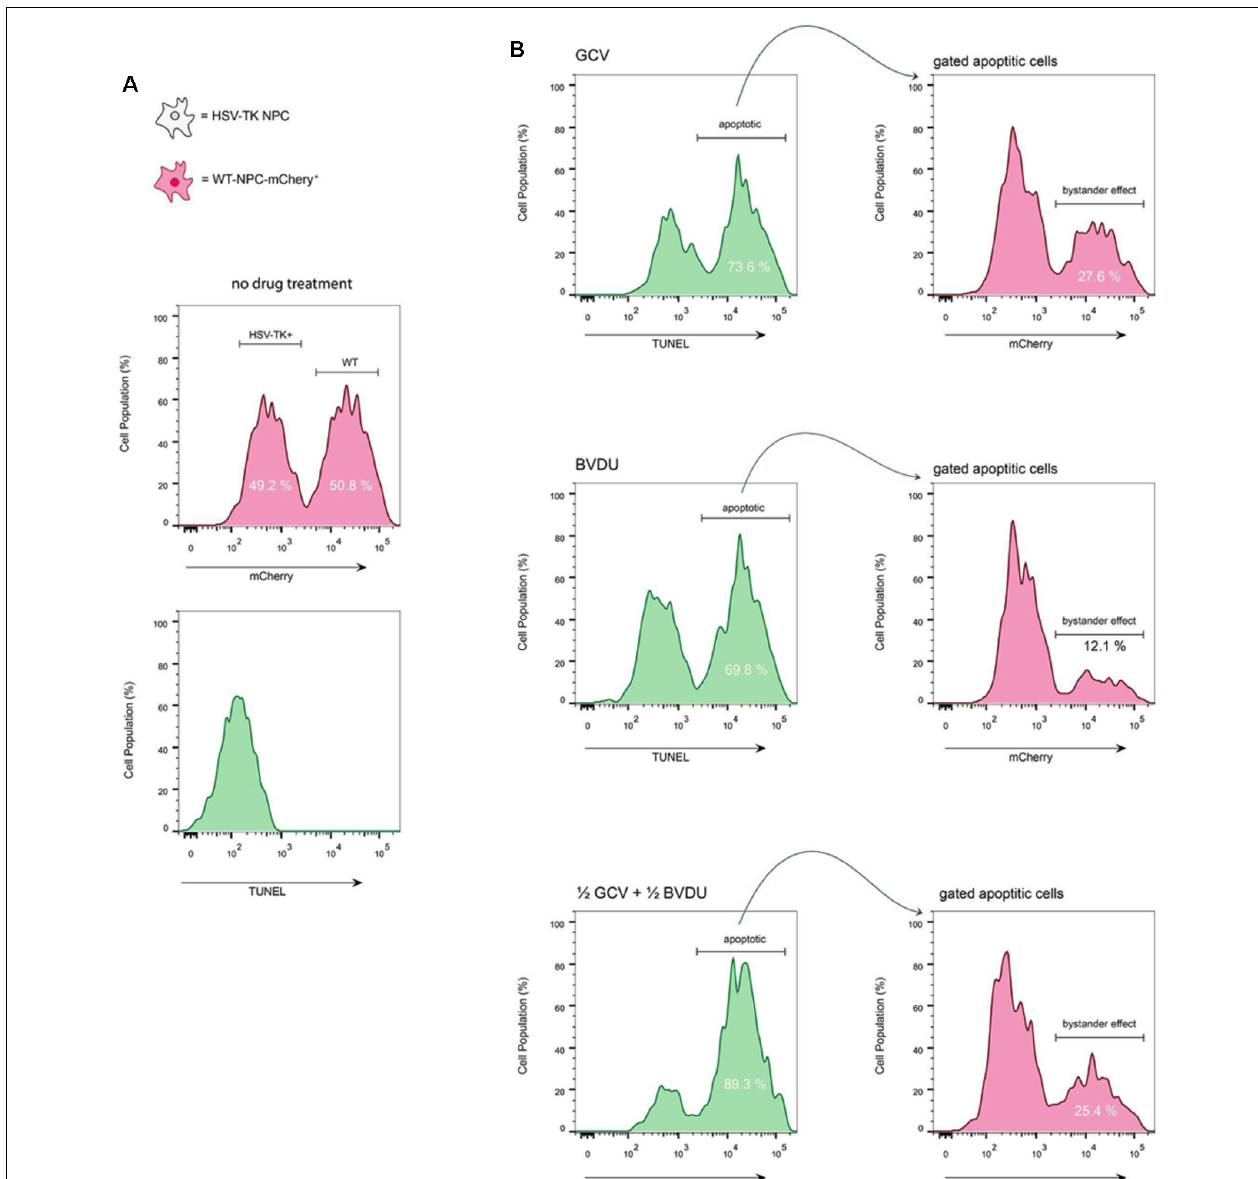
FIGURE 4 | TUNEL assay of co-cultured HSV-TK + NPCs and WT-mCherry + NPCs. (A) To assess the bystander effect by either GCV or BVDU, wild type NPCs that express mCherry were co-cultured with HSV-TK expressing NPCs at a 1:1 ratio. Analysis of the cells before treatment with drugs shows the populations of both WT and HSV-TK cells to be close to 50% (top). Staining untreated cells with a TUNEL kit shows no apoptotic cells at this stage (bottom). (B) A mixed culture of cells was treated with the highest effective dose of either GCV (1 µ g/ml; top panel), BVDU (1 µ g/ml; middle panel), or a combination of both at a 1:1 ratio (0.5 µ g/ml GCV and 0.5 µ g/ml of BVDU; bottom panel). After 96 h, all cells, including both attached and floating, were fixed with 4% PFA, and stained with TUNEL kit.